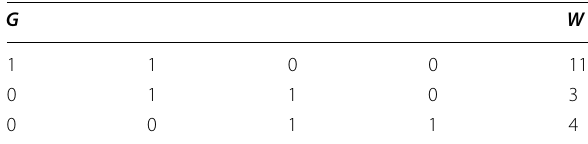
Table 2 Inequality constraint data for the first